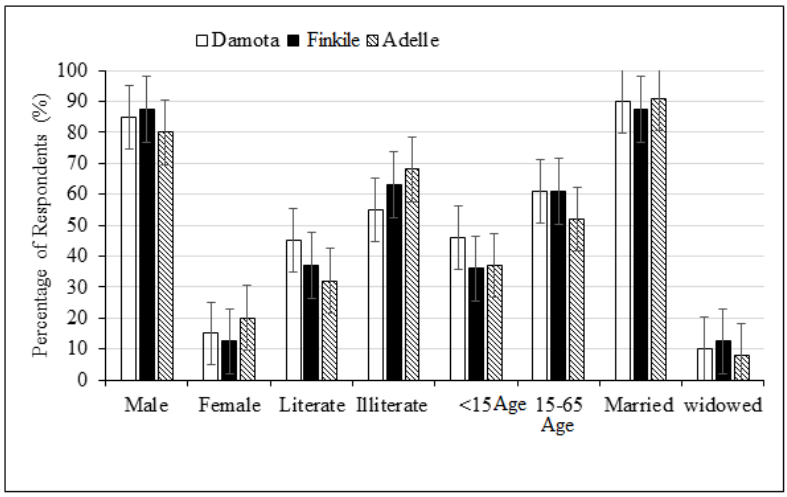
Figure 2. Background information of respondents used for this study. Source: Elaborated by the Authors.